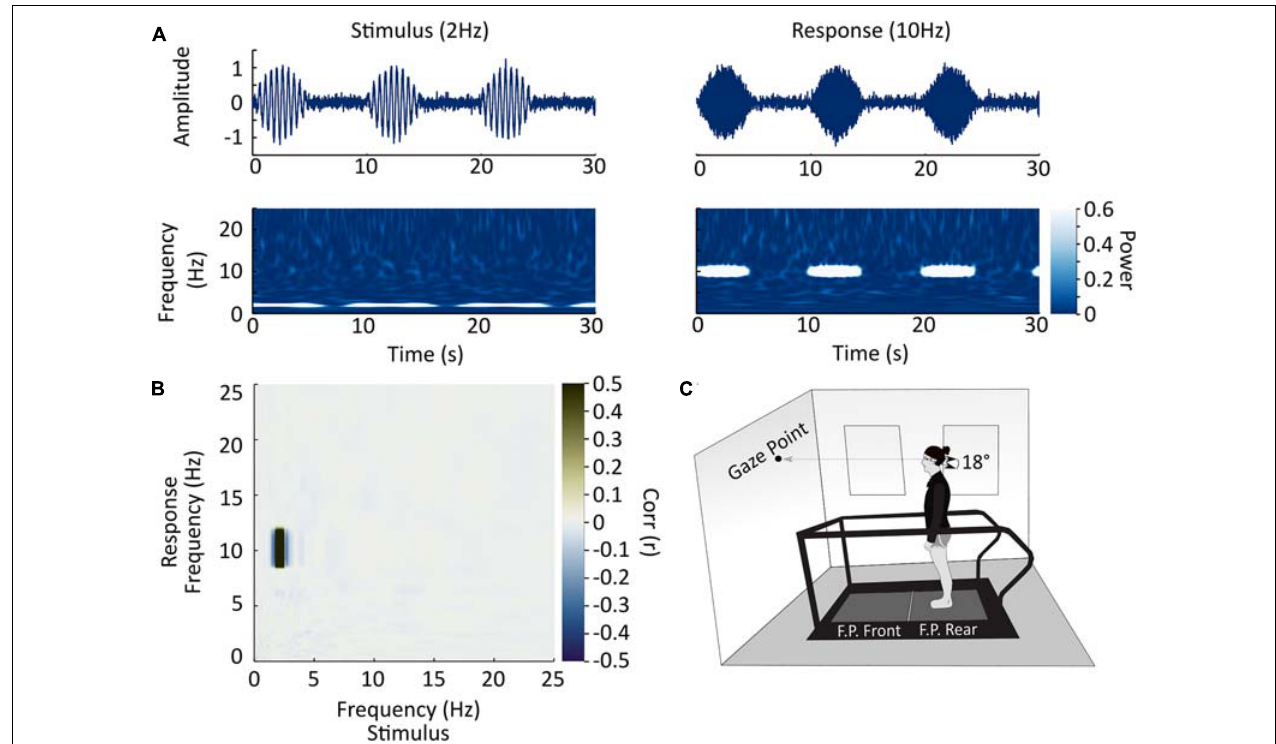
FIGURE 1 | Experimental methods and setup. (A) Analysis example. In this study, we sought to examine co-variation in power between all stimulus and response frequencies to determine if a given frequency of stimulation resulted in a response at the same or a different frequency. The top row illustrates two simulated time-varying signals which are phase locked (co-modulated by the positive component of a 0.1 ± 0.06 Hz sinewave with negative values replaced by zeros) and vary in time at different frequencies (2 Hz stimulus inducing a 10 Hz response). The second row illustrates the modulation of signal power over time in these two time-series. Power amplitude is represented by the scale bar on the right of the figure. (B) In each subject, after alignment in time, we correlated the modulation in signal power over time between the stimulus and response (medio-lateral forces at the feet) for each combination of frequencies and represented these correlations as a response frequency by stimulus-frequency correlation matrix. In this simulated case, the stimulus contained 2 Hz power (see Figure 1A ) and the response contained 10 Hz power, and therefore a correlation is observed at the intersection of these two frequencies. Correlation strength is represented by the scale bar on the right of the plot. (C) Schematic of the experimental set-up. Participants stood on the back force-plate of a two force-plate instrumented treadmill and held their gaze in an orientation meant to keep the head tilted 18 ◦ nose up. This head orientation focuses the postural response to the stimulus to the medio-lateral